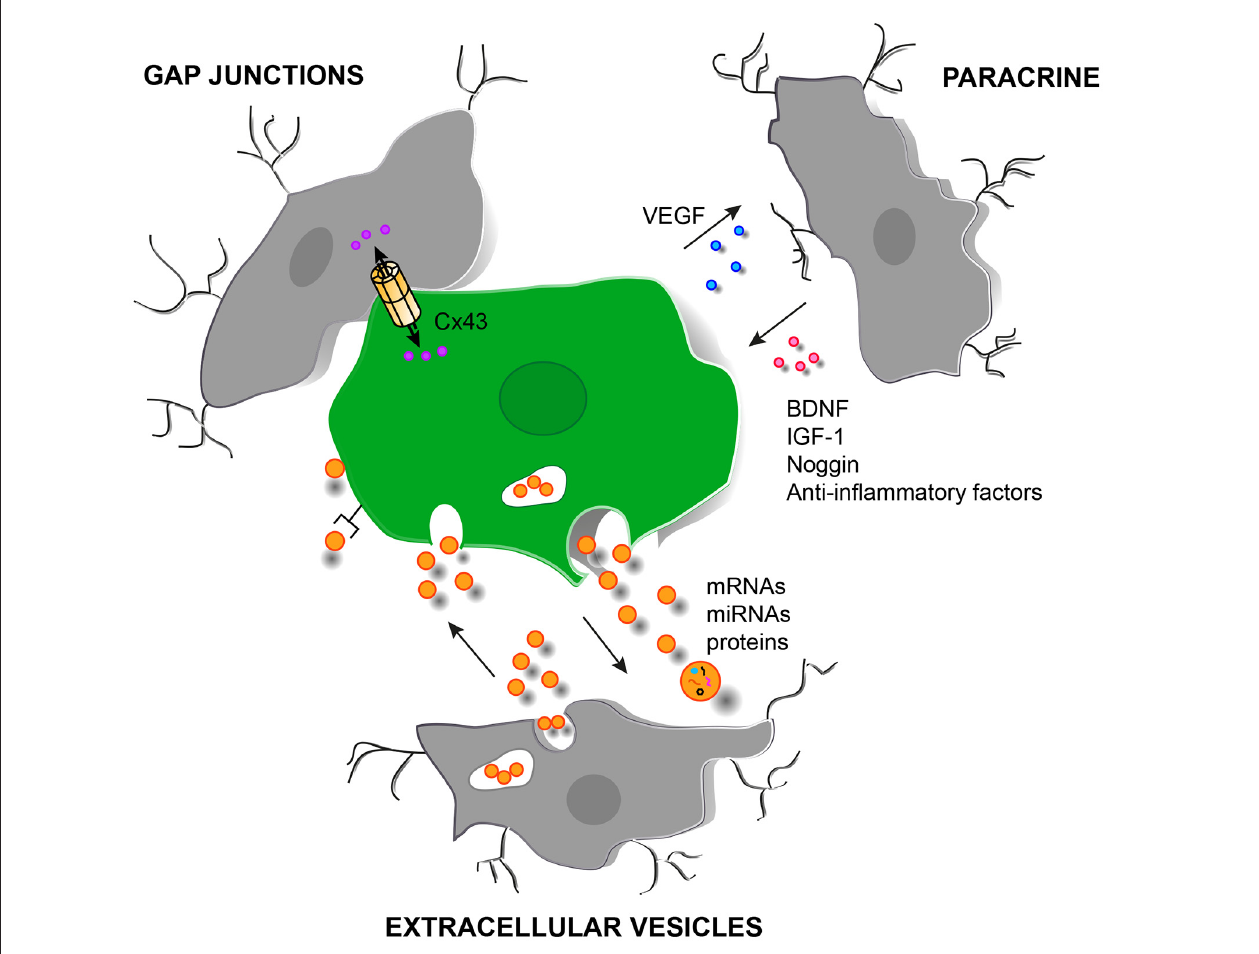
FIGURE 2 | Schematic representation of different cell signaling pathways involved in the interaction between grafted NPCs and host microglia in the injured brain. Paracrine signaling with the release of soluble factors from SVZ-derived NPCs (in green) and microglia (in gray). Direct molecule interchange mediated by gap junctional communication can also occur between microglia/macrophages and grafted NPCs. In addition, extracellular vesicles (orange circles) can be released by NPCs and by microglia with the possibility to deliver bioactive molecules such as mRNAs, miRNAs and proteins. The delivery can be carried out in different ways: (i) by endocytosis of the vesicle; (ii) by activation of surface receptors; and (iii) by membrane fusion or by a Cx43-dependent mechanism. Abbreviations: BDNF, brain derived-neurotrophic factor; Cx43, connexin 43; IGF-1, insulin-like growth factor 1; VEGF, vascular endothelial growth